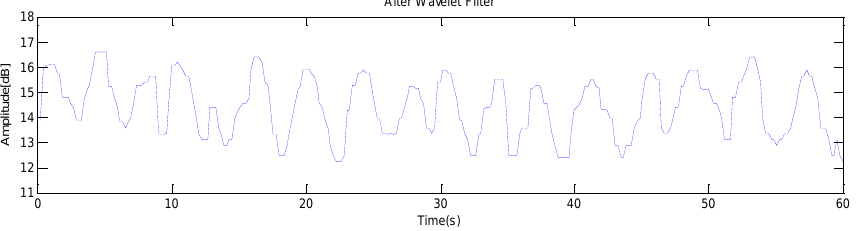
Figure 13. Filtered WCI for normal breathing using C-Band.